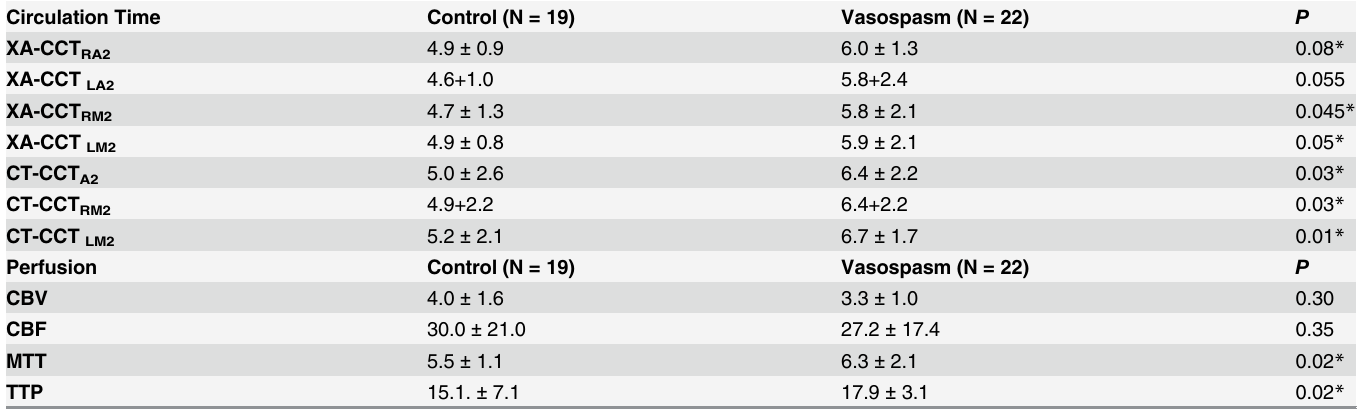
Table 3. Different cerebral circulation times, and perfusion parameters between vasospasm and control